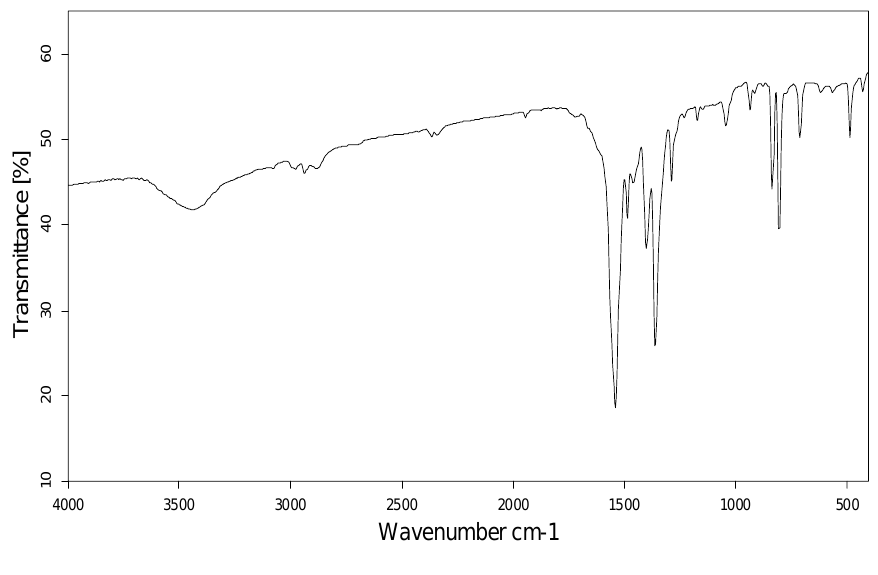
Figure 12. The FT-IR figure of